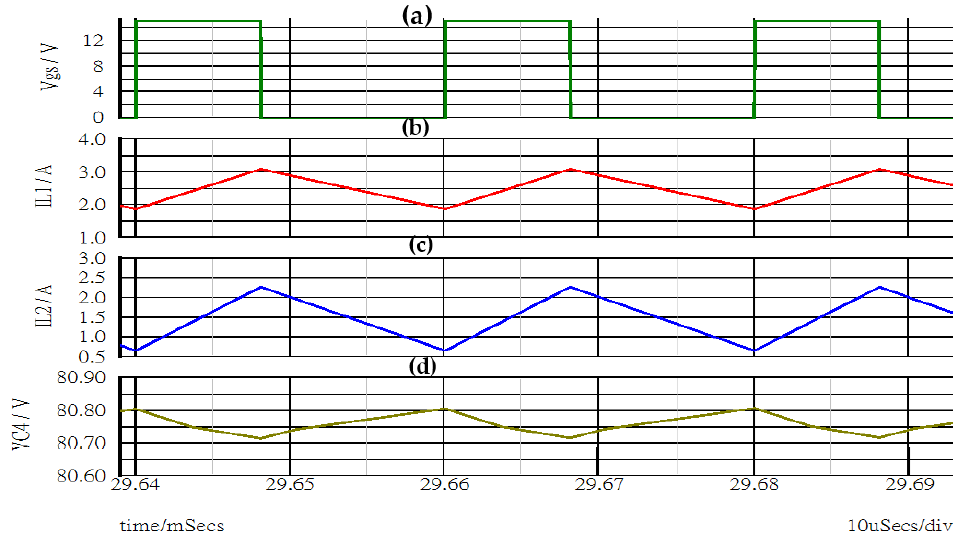
Figure 17. Simulated waveform of ( a ) duty cycle (V gs ) at duty d = 0.402, ( b ) Inductor ( L 1 ) Current